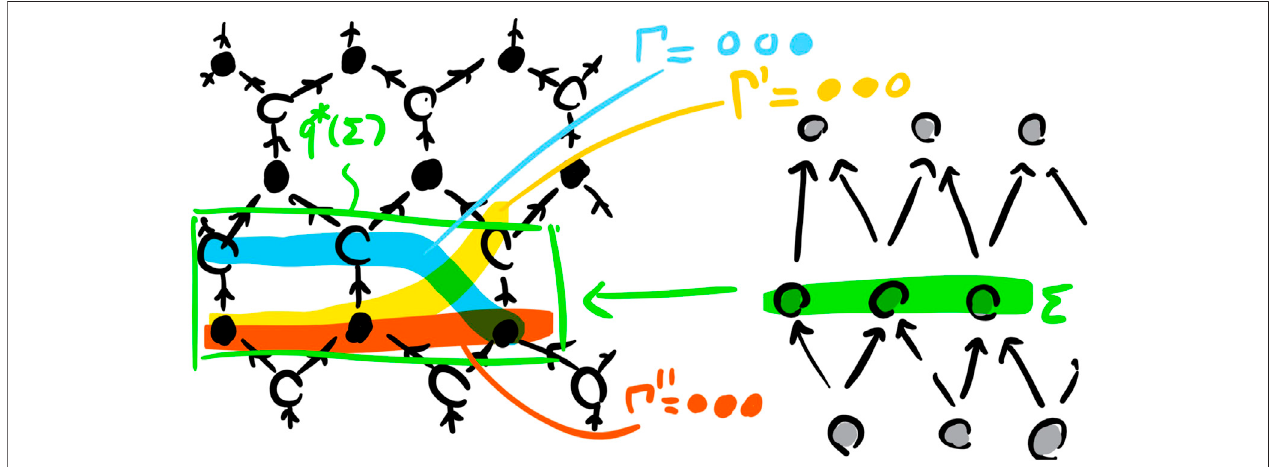
FIGURE 6 | A slice Σ on the diamond lattice and three maximal slices Γ , Γ ′ and Γ ′′ in its pullback q p ( Σ ) on the honeycomb lattice.